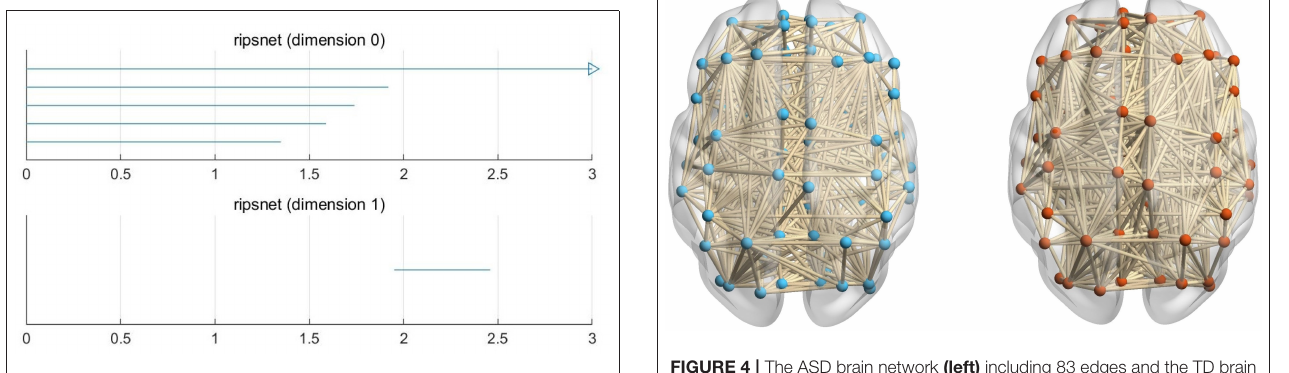
Frontiers in Human Neuroscience |